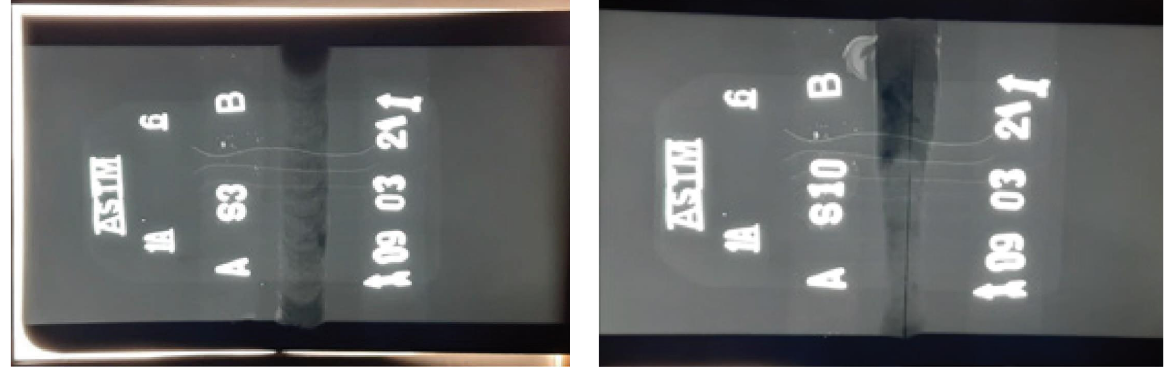
Figure 12: X-ray radiography images of the welded